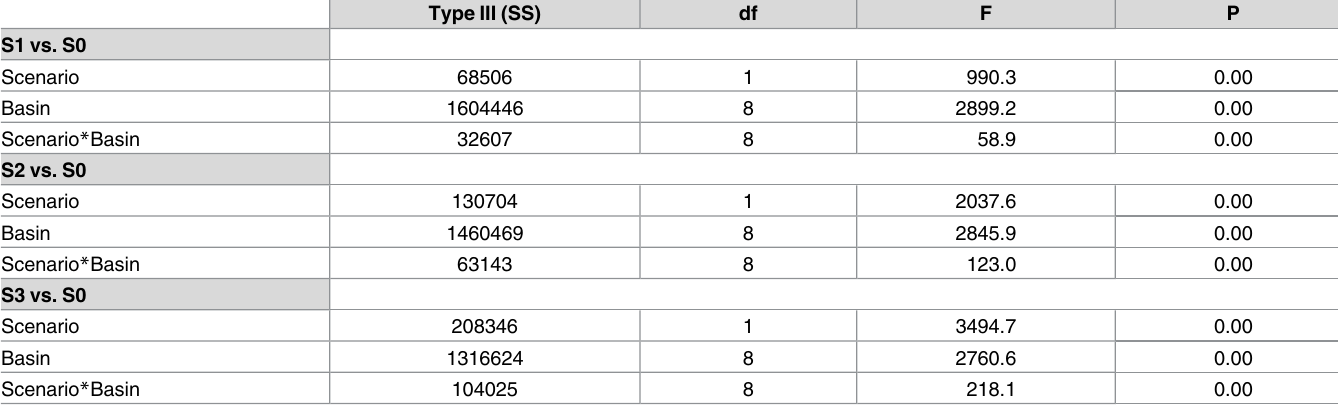
Table 1. Summaryof the univariate ANOVA on the predicted effectvariations from the starting actual conditions scenario (S0) towards progres- sive comparative consecutivevariation scenarios river basin, and their interactions on taxa